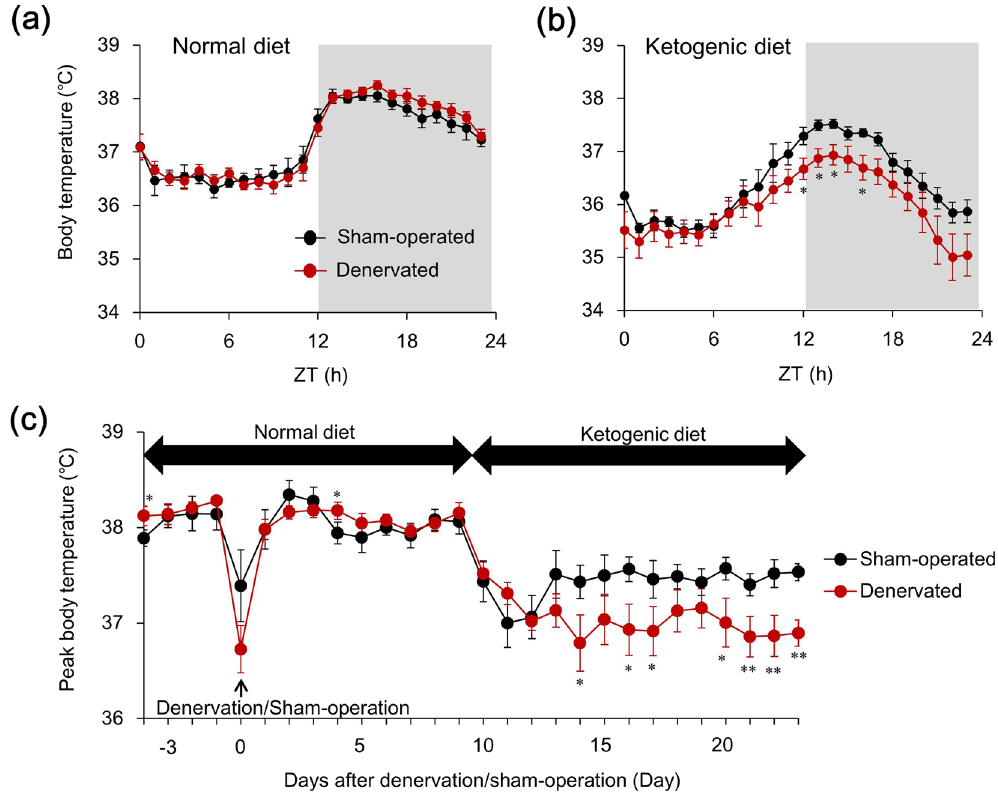
Figure 5. Bilateral sciatic denervation exacerbates hypothermia during prolonged ketogenic diet feeding. Core body temperature rhythms for 24 h in mice fed with ketogenic (KD) or normal (ND) diets for two weeks starting at 10 days after sham operation or bilateral sciatic nerve transection. Hourly averaged values of body temperature on the day before starting ( a ) and after two weeks ( b ) on ketogenic diet. Gray shading indicates dark period. ( c ) Peak values of body temperature during experimental period. Body temperatures were averaged every two hours from ZT13 to ZT15. Data are expressed as means ± SEM (n = 5–7 per group). * P < 0.05 and ** P < 0.01 for sham-operated vs. denervated. ZT, zeitgeber time. Supplemental Tables 5 and 6 show results of statistical